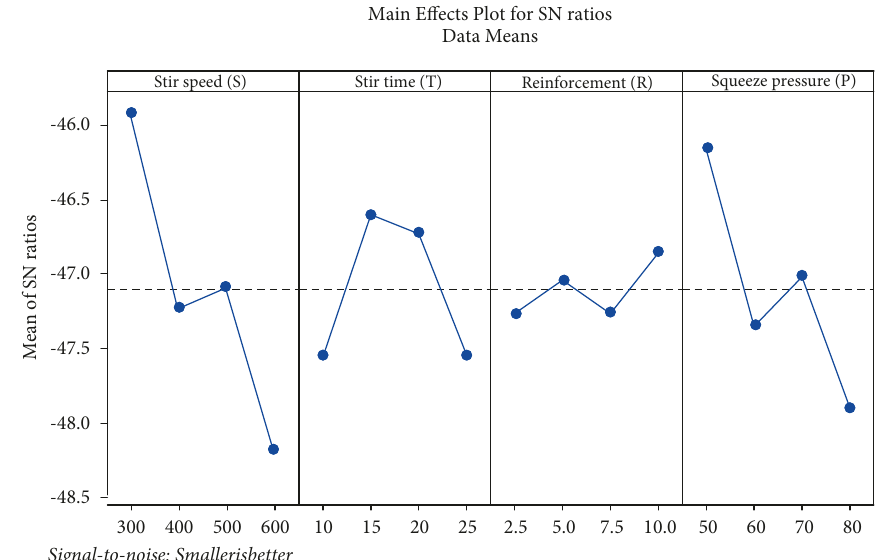
Figure 11: Mean of SN ratio